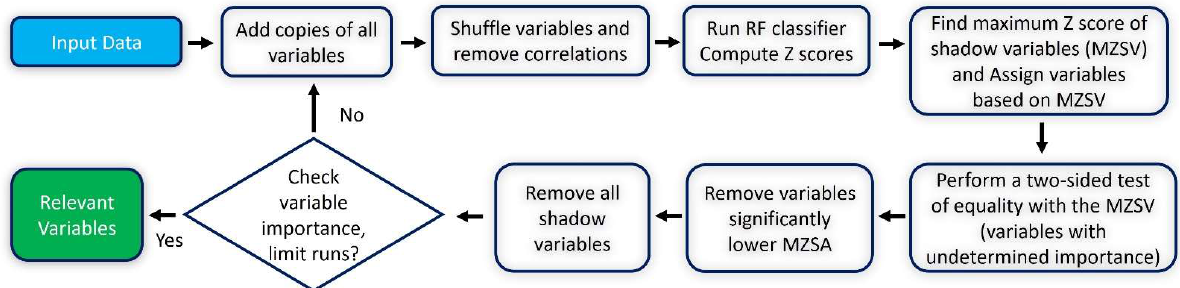
Figure 3. Overview of the Boruta feature selection method.